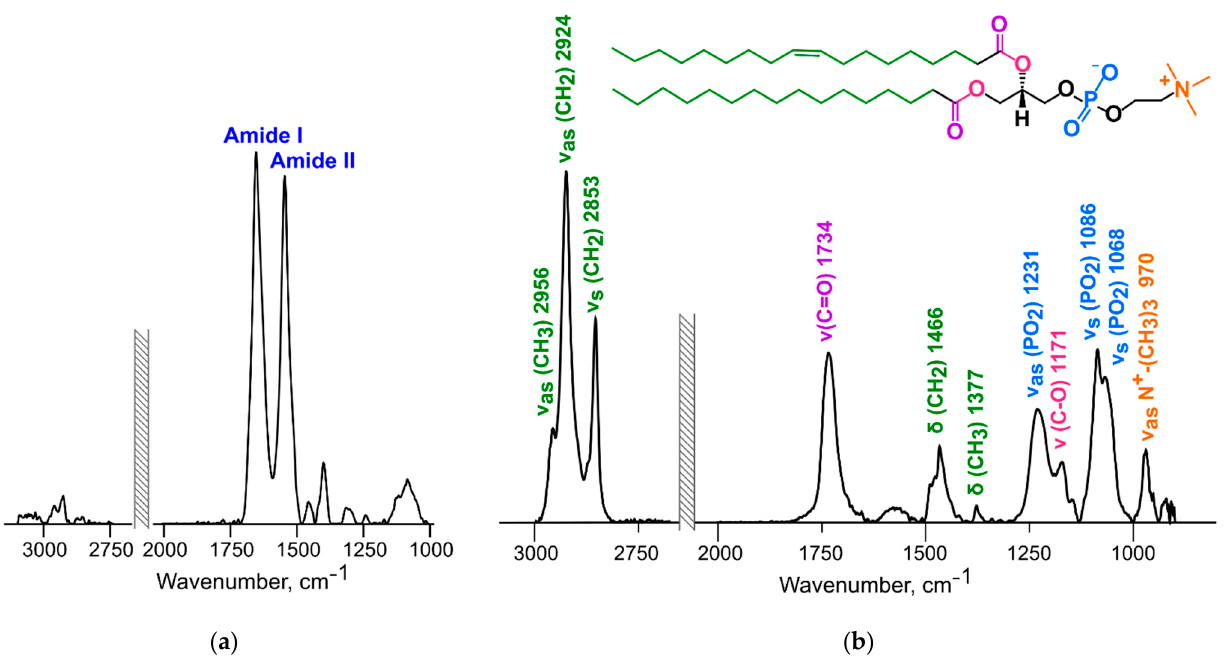
Figure 6. Albumin ( a ) and liposome ( b ) FTIR spectra recorded in PBS at 37 ° С .